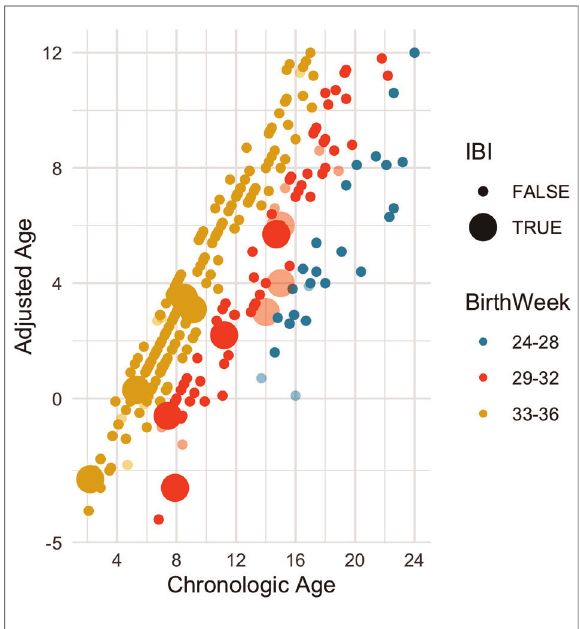
FIGURE 2 A scatter plot of all 290 included cases. Faded out are infants who were ill appearing to begin with. The observations are shown by the adjusted-age (y-axis) and chronologic-age (x-axis) in weeks. Enlarged icons indicate a positive culture. As can be seen, the IBI cases continue to be prevalent beyond 60 days chronologic-age, but almost all cases fall under 28 days adjusted age.